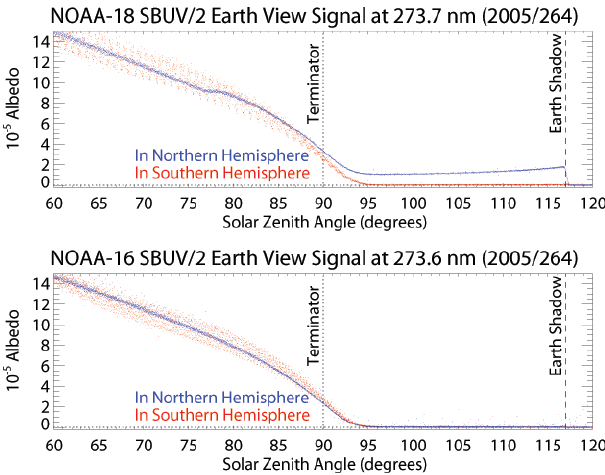
Fig. 1. Solar backscattered ultraviolet spectrum measured by NOAA-16 SBUV/2. The monochromator completes a continuous spectral scan from 405 to 160nm in 168s. The radiance spec- trum (top panel) is an average of 60 scans between the latitudes of 15 ◦ S and 15 ◦ N, which were taken during four consecutive orbits once per week in November 2001. The albedo spectrum (bottom panel), equal to the radiance spectrum divided by the solar irradi- ance spectrum, is used in the ozone retrieval. Square symbols rep- resent SBUV/2 discrete wavelengths used for ozone measurements in a 32s scan cycle. The diamond shows the location of the cloud cover radiometer (CCR) measurements.